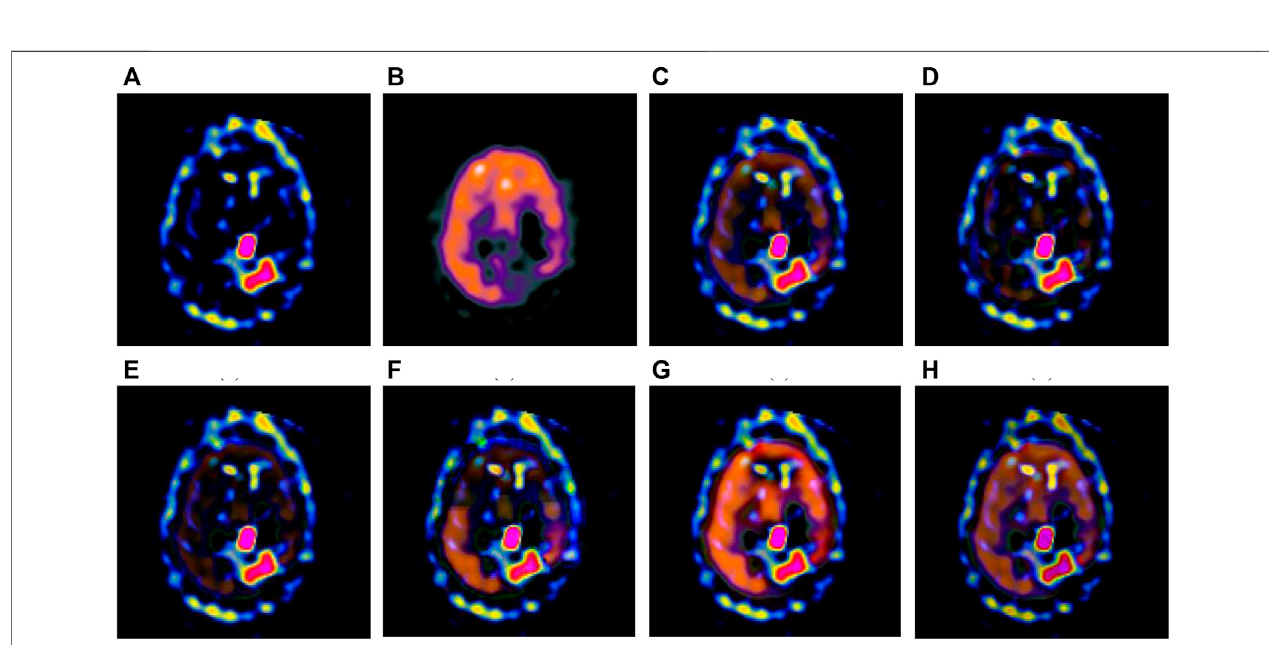
FIGURE 4 | Fusion results of the second group. (A) Source image SPECT-TL2 (B) Source image SPECT-TC2 (C) Laplacian Pyramid (D) DWT-DBSS (E) SIDWT- Haar (F) Morphological Difference Pyramid (G) SR (H) GA-SR.